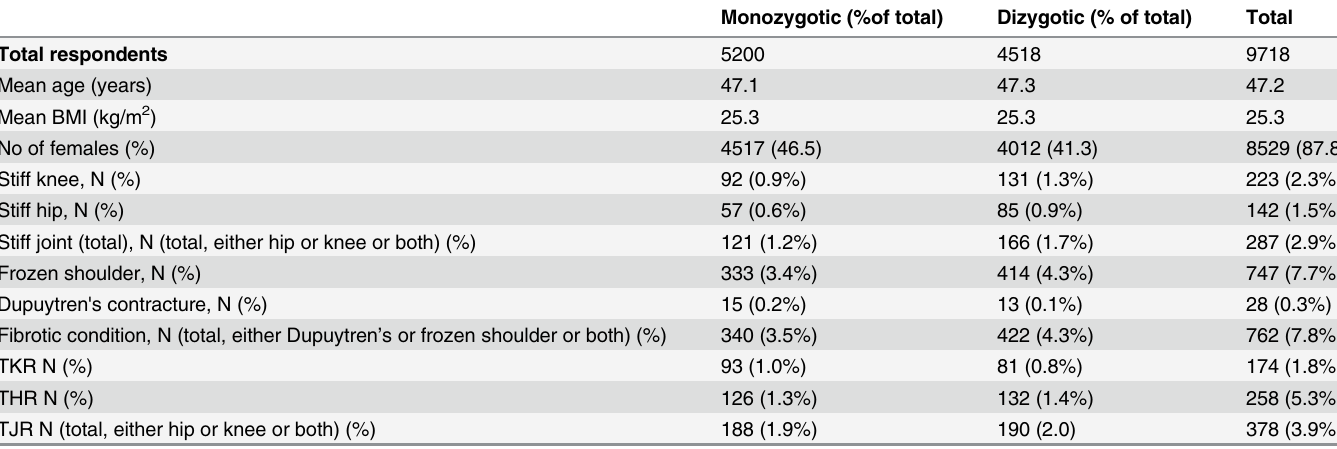
Table 1. Characteristics of the TwinsUK sample, by